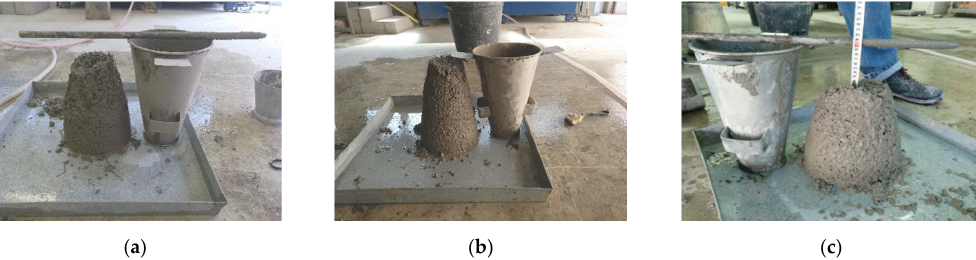
Figure 6. Examples of the visual aspect of the concrete mixes: ( a ) Batch 3, P1 MSFRC; ( b ) Batch 6, MSFRC; and ( c ) Batch 7, SFRC.